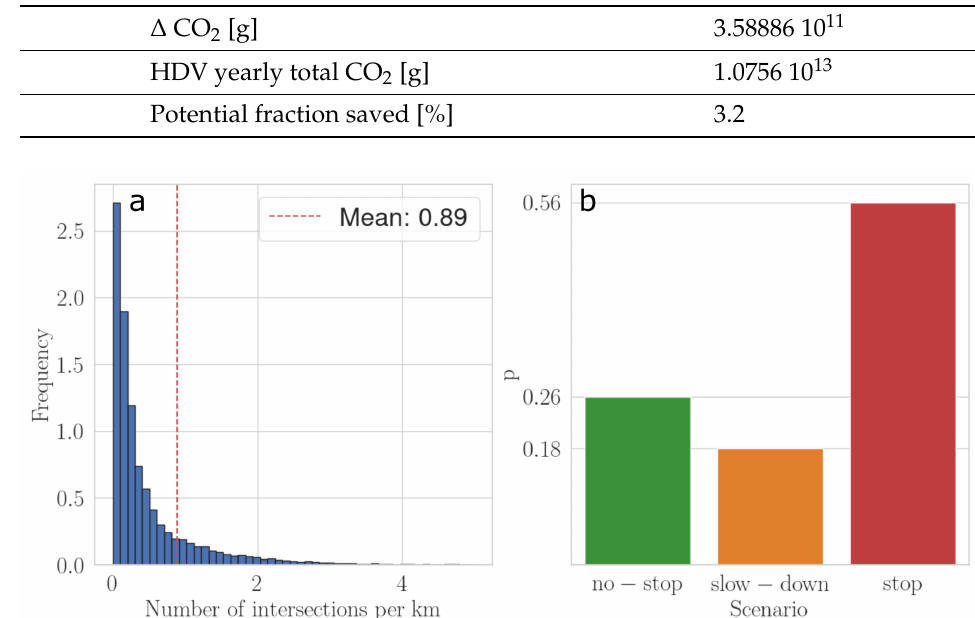
Table 3. Potential energy savings from HDV in The Netherlands by using C-ITS. The first row shows the value of ∆ as defined in Equation (9), that is, the yearly potential CO 2 savings, in this case for 2019. In the second row is the 2019 total CO 2 emitted by HDVs as reported by the CBS. Finally, in the third row, we show the percentage that ∆ represents from the total CO 2 .